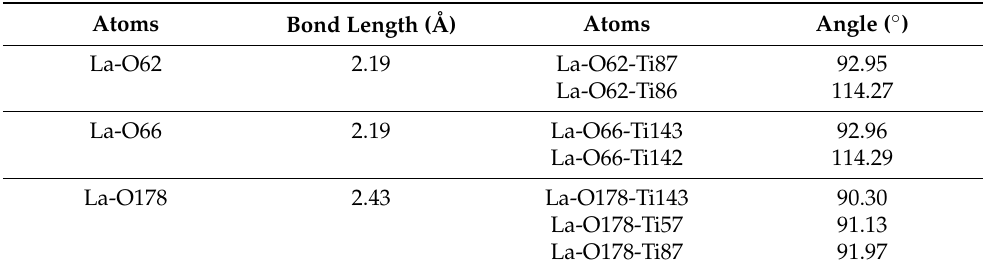
Table 1. Significant bond lengths and angles for La/TiO 2 surface.